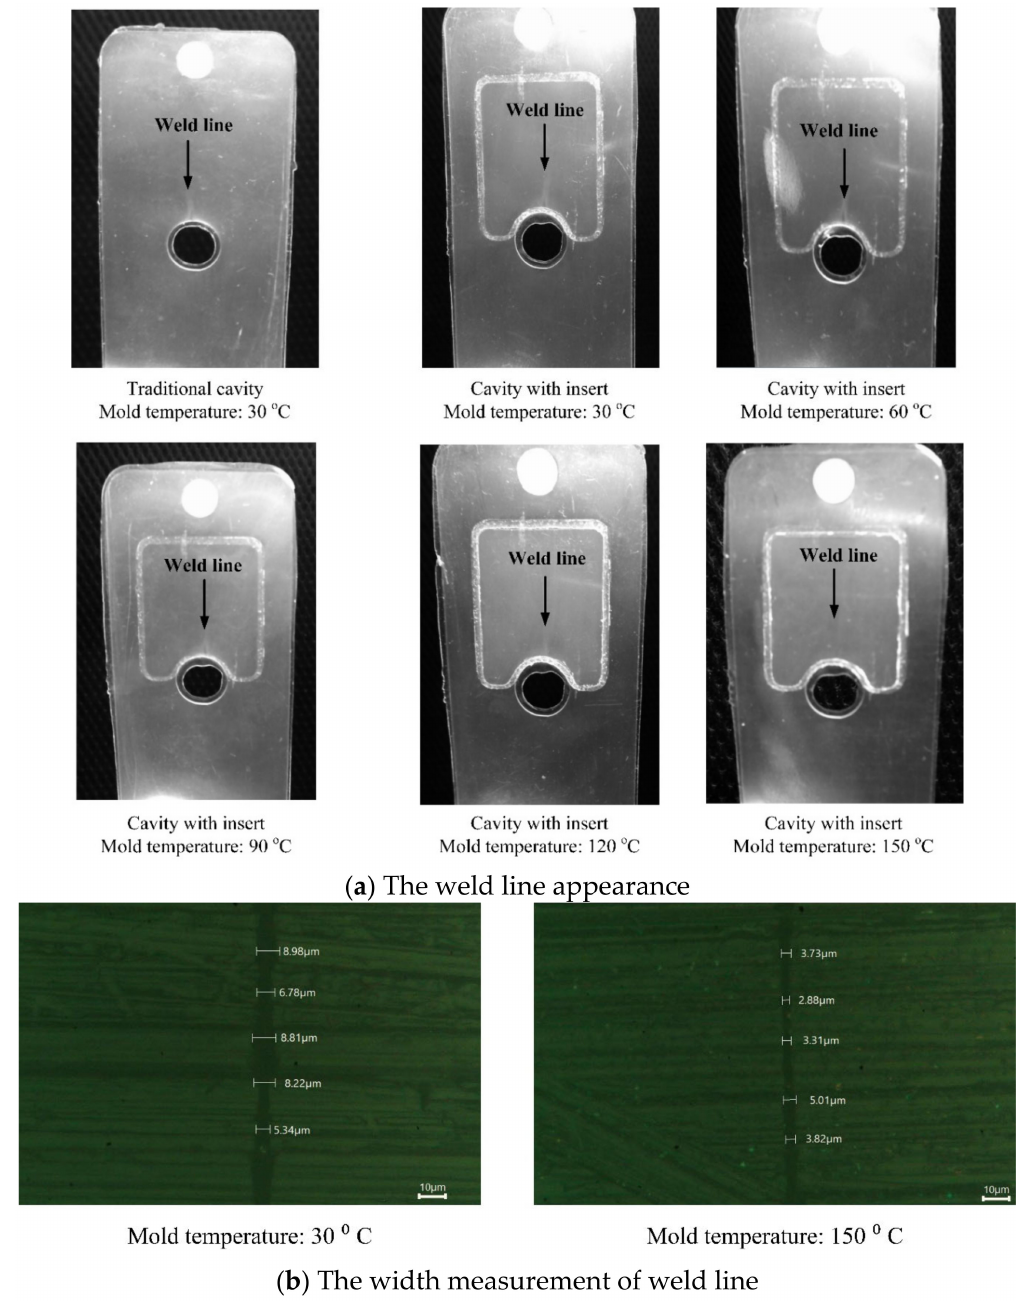
Figure 14. The comparison of weld line appearance ( a ) and weld line width ( b ) at di ff erent cavity